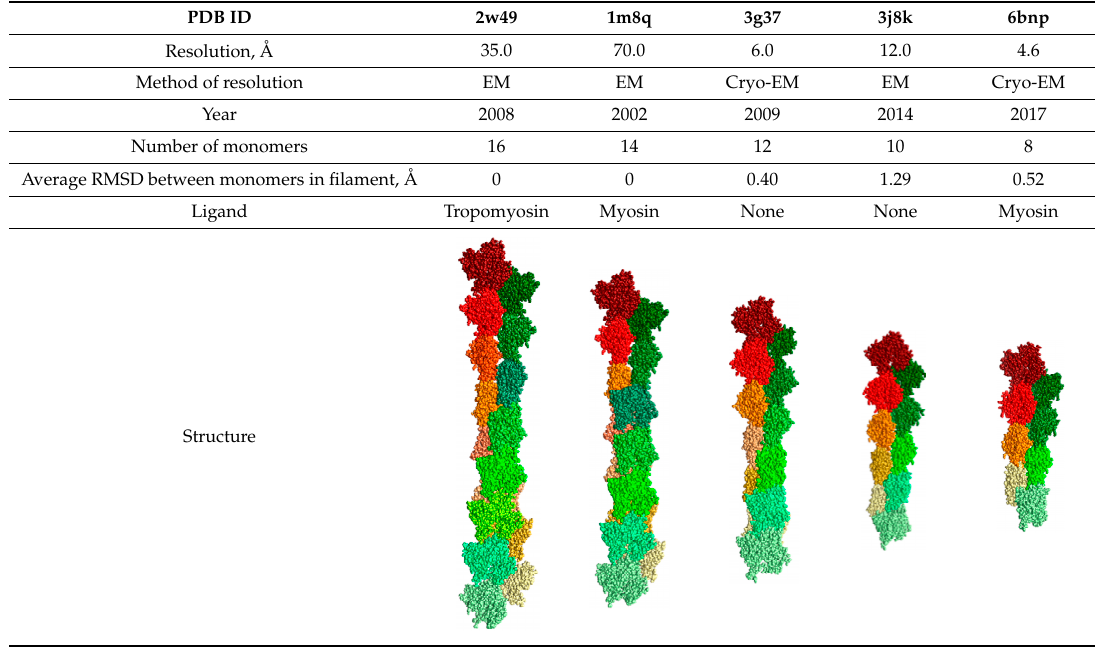
Table 1. Some characteristics of F-actin from the Protein Data Bank. Table 1. Some characteristics of F ‐ actin from the Protein Data Bank. Table 1. Some characteristics of F ‐ actin from the Protein Data Bank. Table 1. Some characteristics of F ‐ actin from the Protein Data Bank. Table 1. Some characteristics of F ‐ actin from the Protein Data Bank. Table 1. Some characteristics of F ‐ actin from the Protein Data